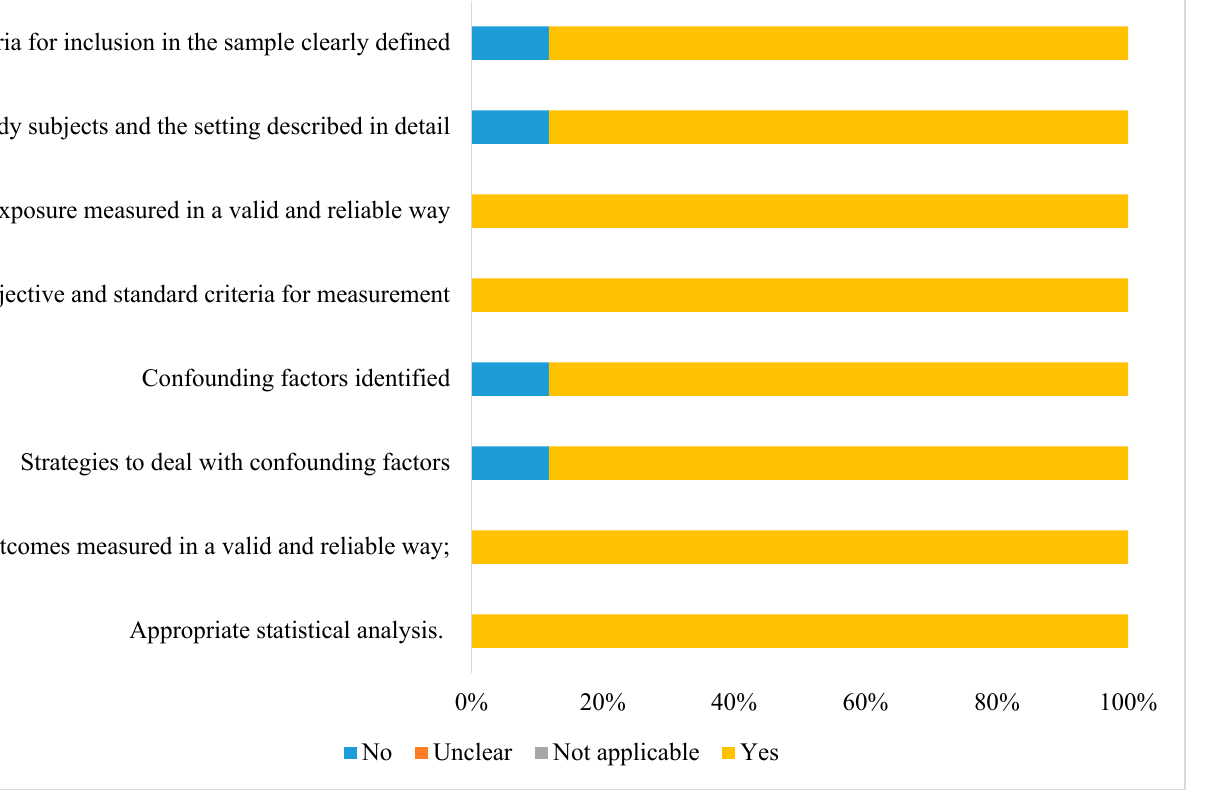
Figure 2. Risk of bias assessment for cross-sectional studies according to the Joanna Briggs Institute’s risk of bias assessment tool [16].